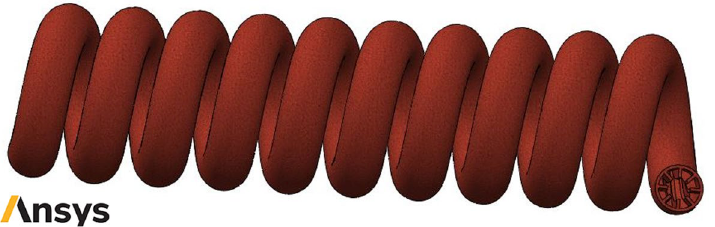
Figure 2. Schematic of studied helical heat exchanger with common turbulators (Images used courtesy of ANSYS, Inc.).